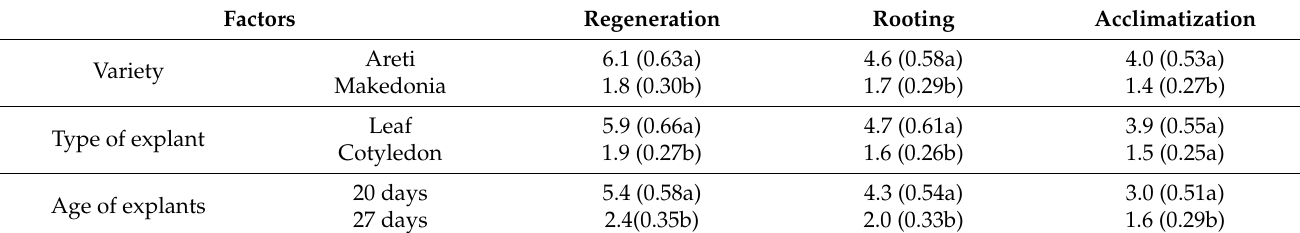
Table 3. Mean value (x) of the regeneration, rooting of regenerated shoots, acclimatization of rooted shoots affected by the main factor variety, and the type and age of explants. Mean values followed by different letters are statistically different, at significance level a = 0.05, according to the results of the ANOVA. Numerical values outside the parentheses are the mean values of raw data and values in the parentheses indicate the mean values of log 10 -transformed data.